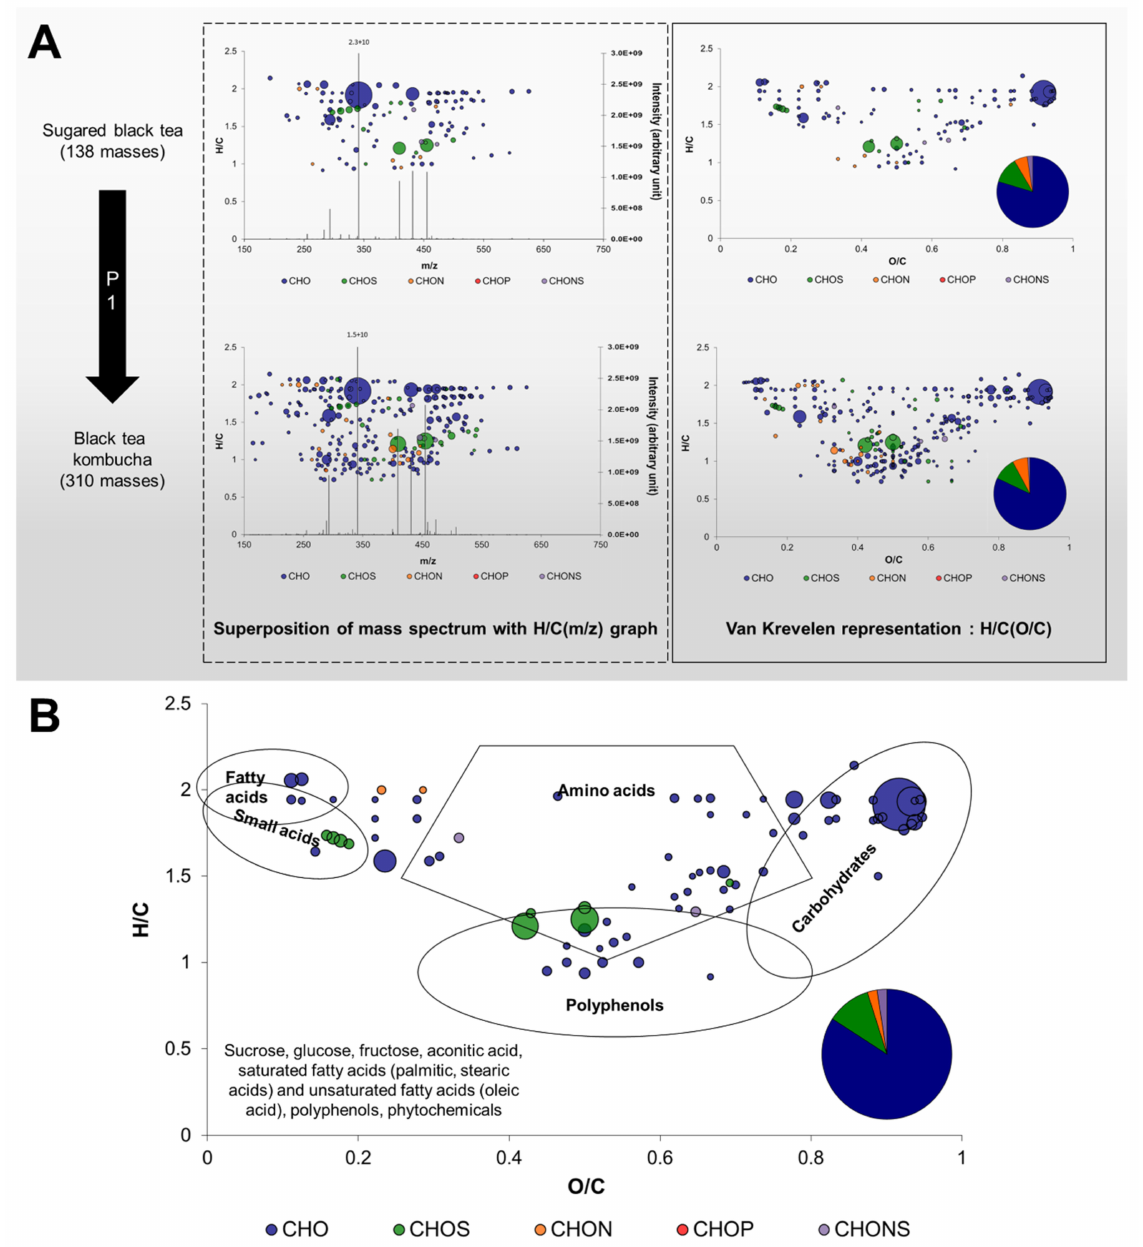
Figure 2. Construction of graphic representations of FT-ICR-MS data. ( A ) From mass spectra, annotation of elemental formula allows to arrange each formula according to elemental ratios (for example H/C) and to distinguish different elemental composition using colors. By arranging formulae using H/C and O/C ratios, Van Krevelen diagrams are obtained and can be complemented with the proportions in different elemental compositions. Enrichment in composition between Sugared Black Tea and corresponding kombucha during the first phase of production (P1) can be observed. ( B ) Van Krevelen diagram of common formula across Sugared Teas and kombuchas at day 7 and day 12, complemented with the proportions in different elemental compositions. The utilization of Van Krevelen diagrams allows the determination of regions corresponding to chemical families such as lipids, small acids, amino acids, polyphenols or carbohydrates, based on the analysis of a large number of compounds [15]. The surface of bubbles expresses relative formulae intensity. With a comparison of mass lists with databased such as METLIN, putative compound identities can be obtained. Most probable candidates were added in the bottom left-hand corner of the